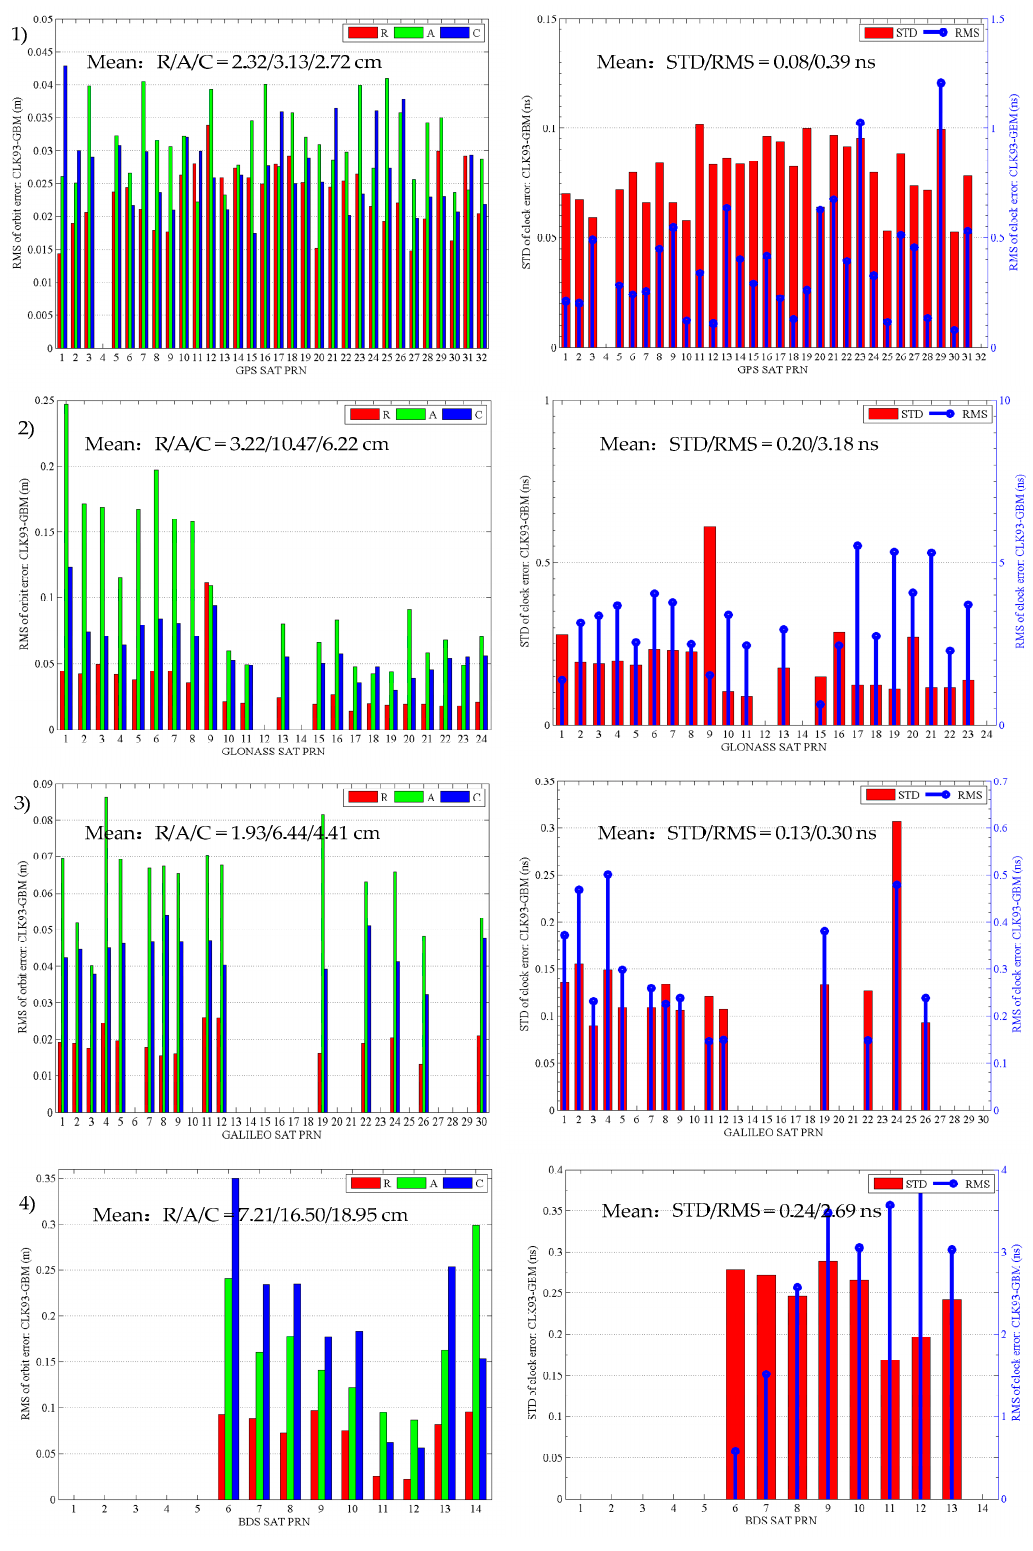
Figure 1. The differences between orbits and clocks calculated based on real-time products with reference to GFZ’s final products: ( 1 ) GPS; ( 2 ) GLONASS; ( 3 ) GALILEO; ( 4 ) BDS.